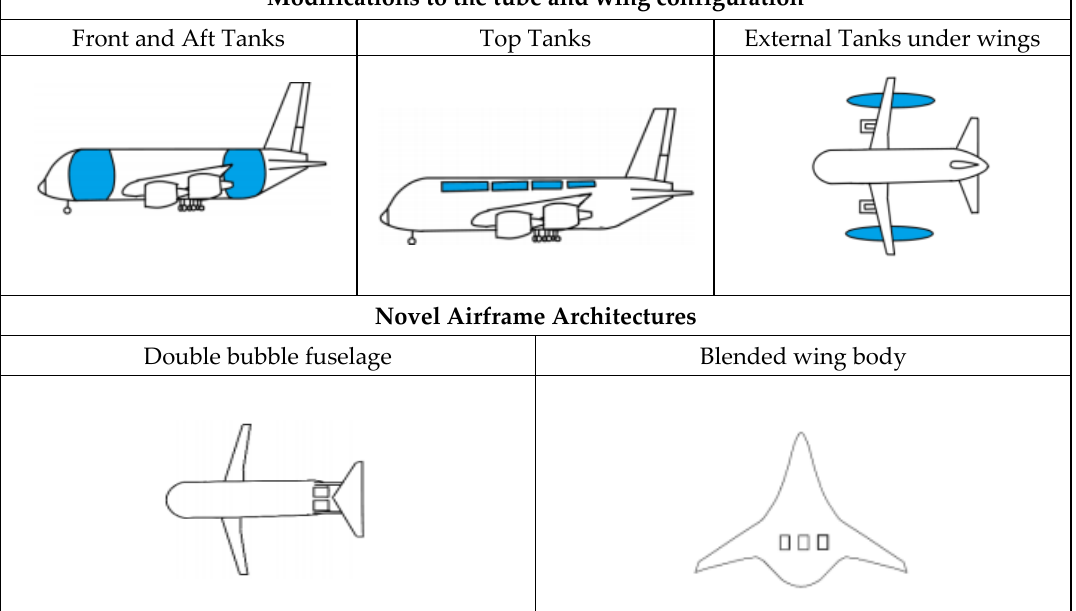
Figure 7. Modifications to the Tube and Wing Configuration Figure 5. Modifications to the tube-and-wing